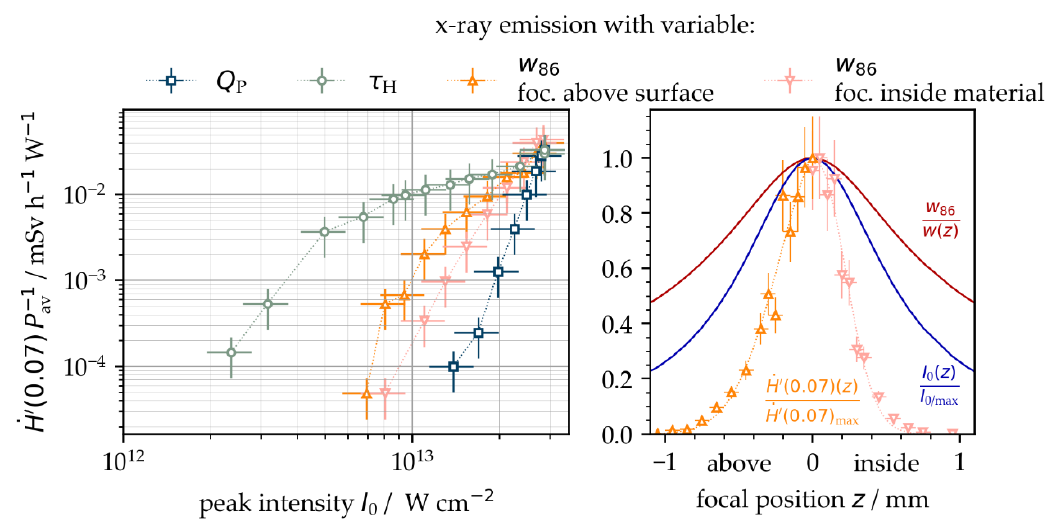
Figure 8. ( Left ): X-ray emission dose rate as function of pulse energy, pulse duration, and laser spot size; ( Right ): effect of laser beam defocusing on laser spot radius, peak intensity, and X-ray emission dose rate obtained at 0.5 MHz PRF, 1.0 µm intra-line pulse distance, and 2.8 m/s ± 0.4/s suction flow speed.